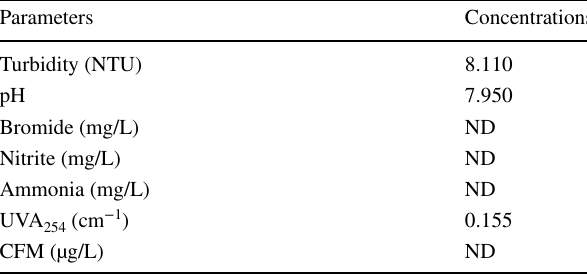
Table 1 General characteristics of the composite water sample col- lecting from Khandaq El-Sharqi canal